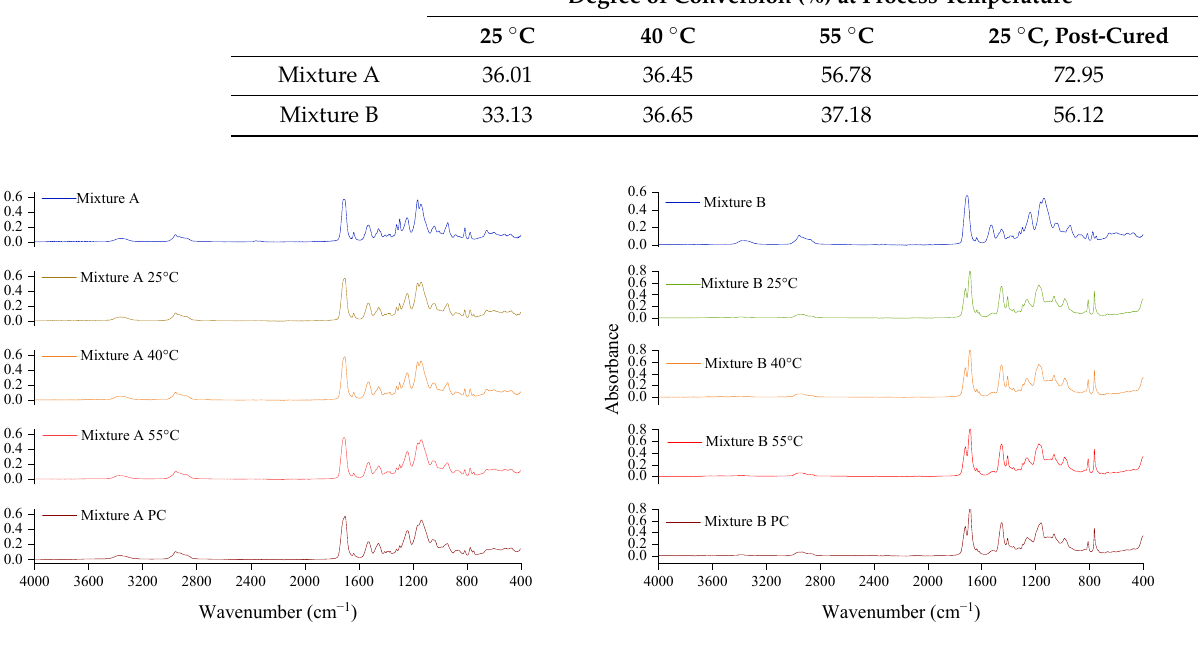
Figure 4. The ATR of the uncured photoresins (Mixture A and Mixture B) as well as their cured networks at different process temperatures.